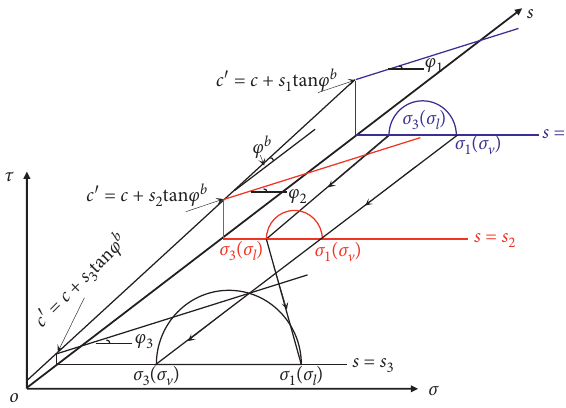
Figure 11: Development of stress state upon wetting. Table 4: Results of laboratory shear strength